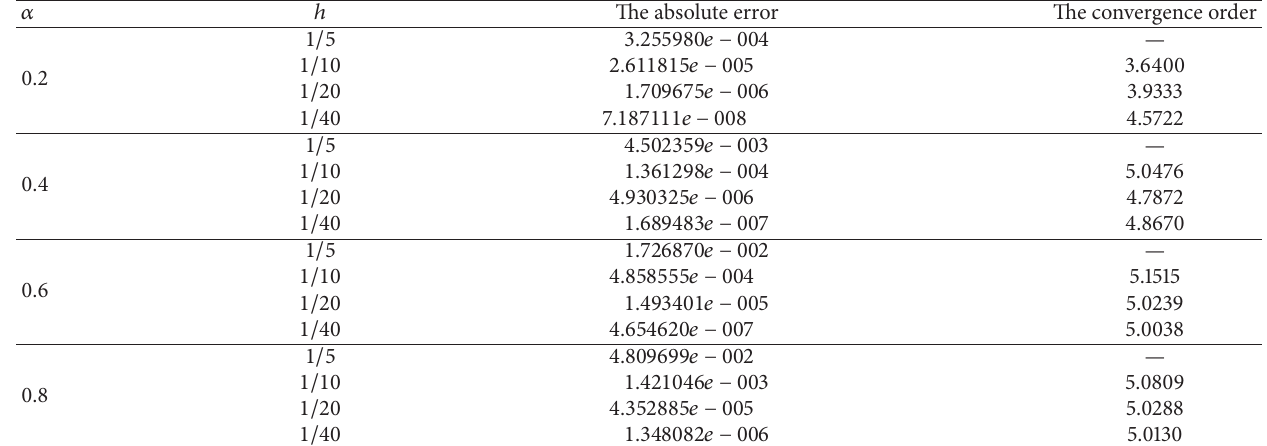
Table 7: The numerical results of the Example 9 by formula (14) with 𝑝 = 5 .